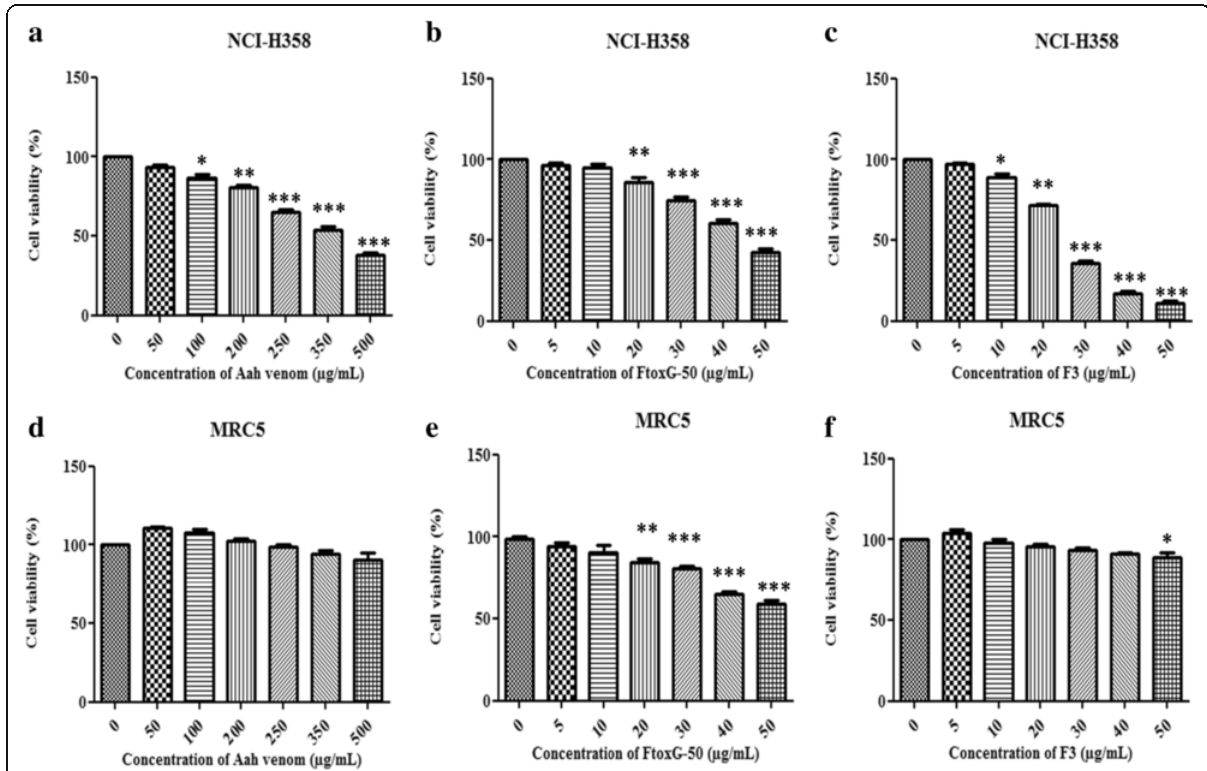
Fig. 1 Dose-dependent effects of Aah venom and its toxic fractions (FtoxG-50 and F3) on the viability of NCI-H358 and MRC5 cells. Cells were treated with different concentrations of ( a , d ) Aah venom, ( b , e ) FtoxG-50 and ( c , f ) F3 fraction for 24 h. Cell viability was determined according to the MTT assay. The data are expressed as the mean ± SD of three independent experiments in triplicate. Significances are shown in comparison to control cells (* p < 0.05; ** p < 0.01; *** p <